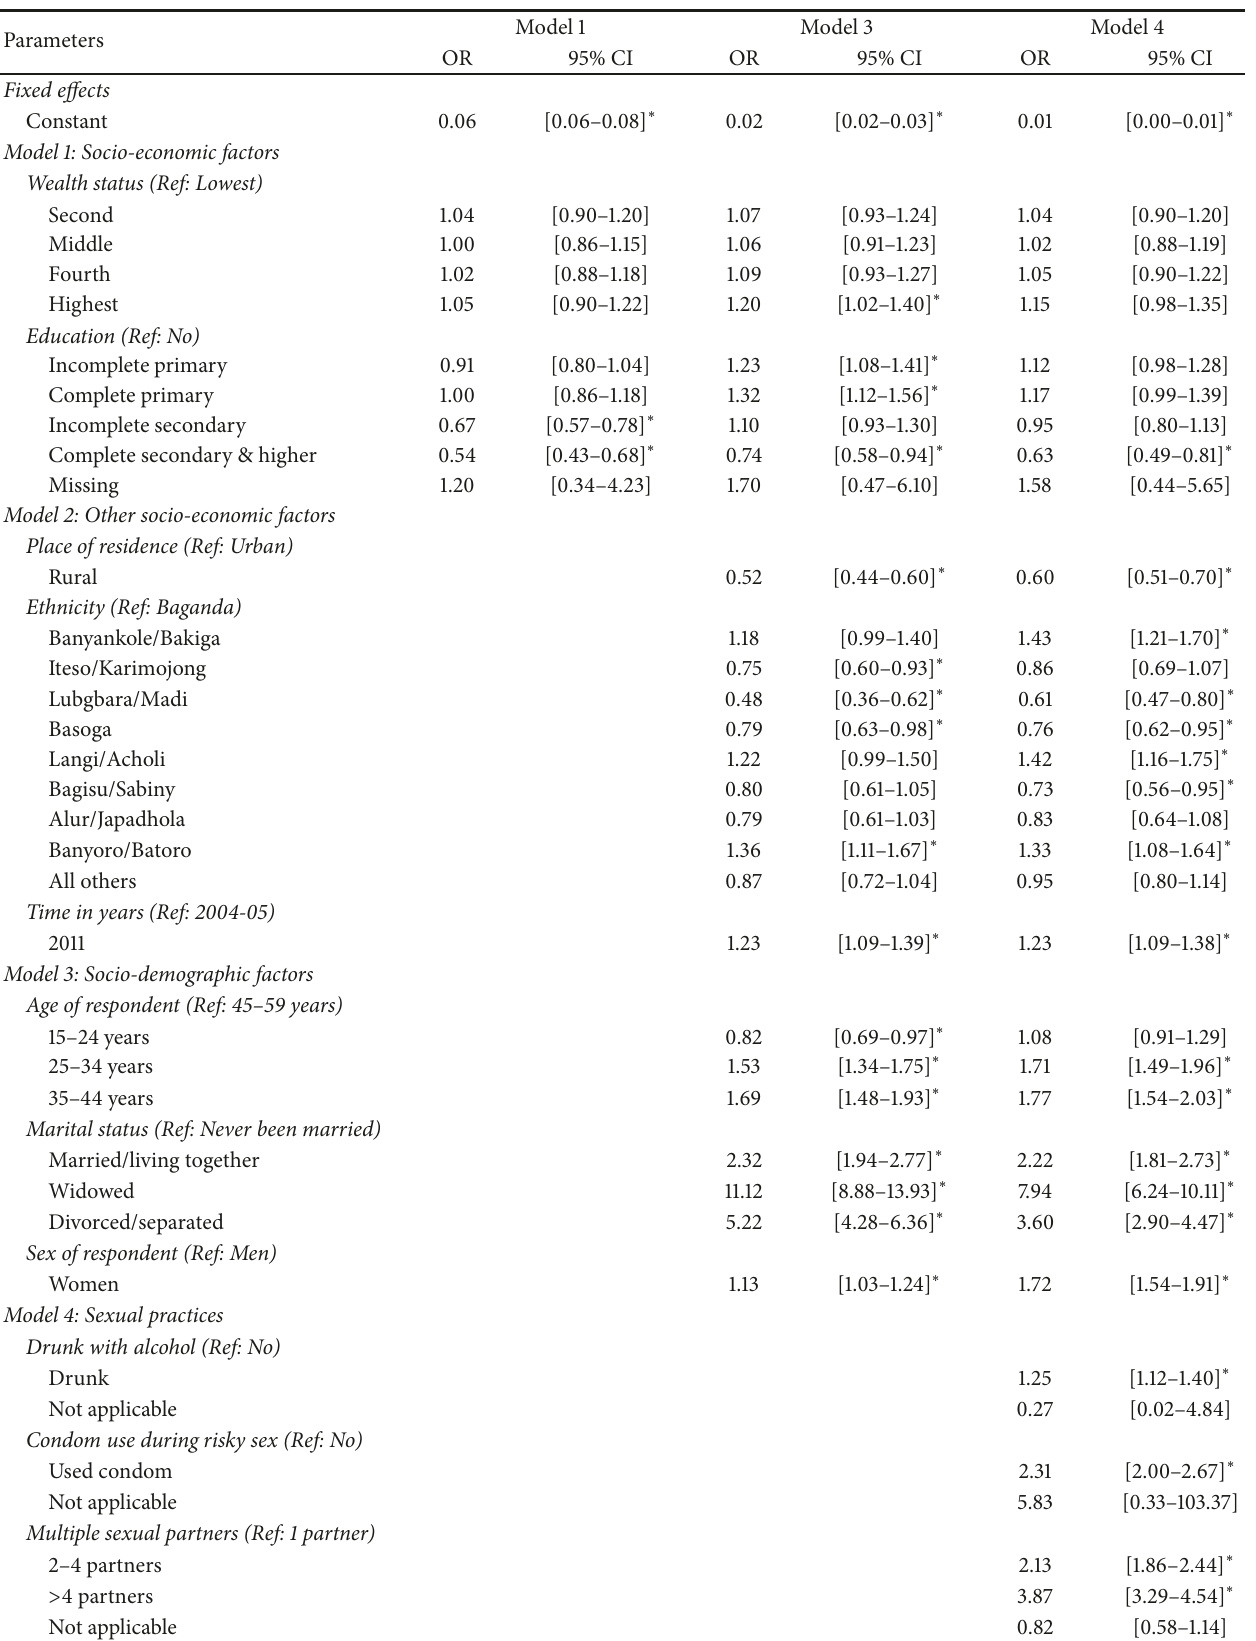
Table 2: Odds ratios (OR) of being HIV positive for women and men, Uganda AIS, 2004-2005 and 2011 ( 𝑛 = 39 , 766 ).